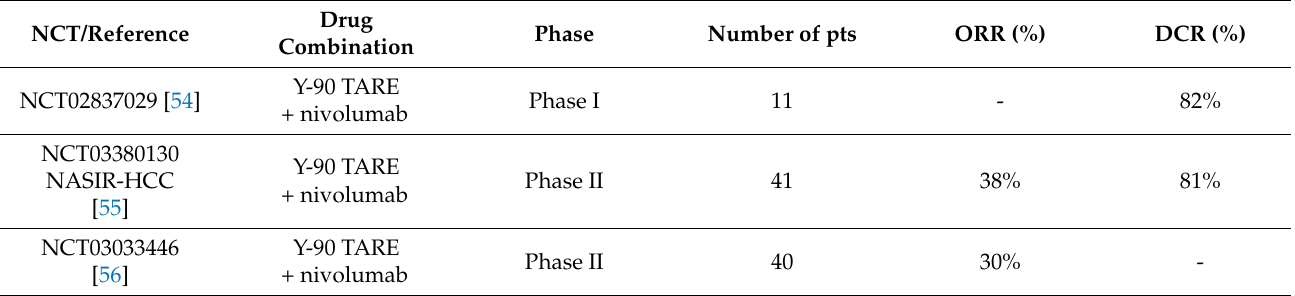
Table 6. Completed trials of immune checkpoint inhibitors in combination with Y-90 trans- arterial